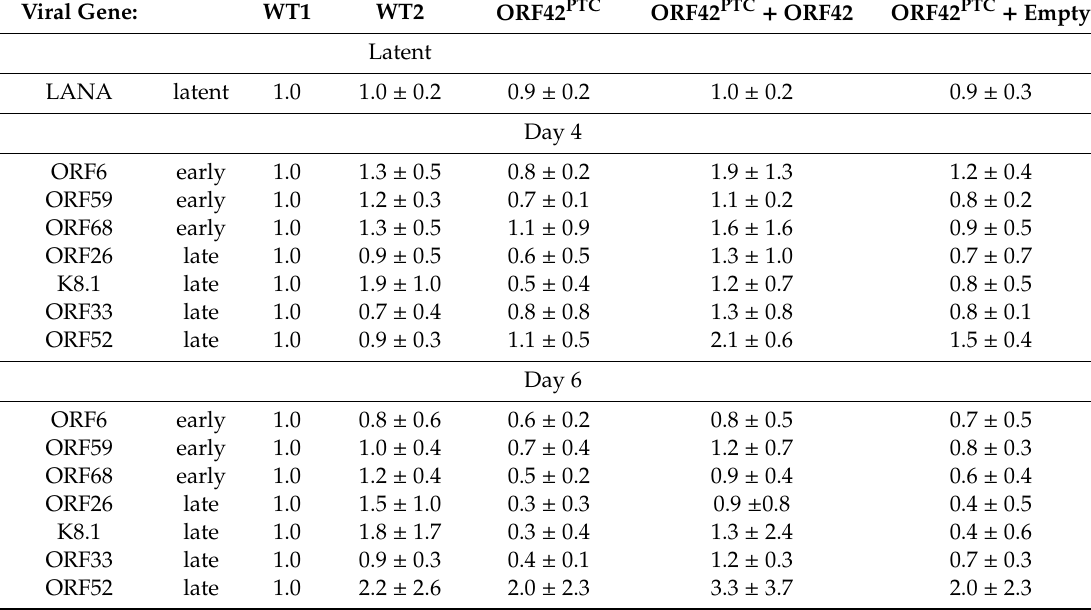
Table 2. Quantification of KSHV protein levels. Average expression and standard deviation of levels of KSHV proteins relative to the WT1 line. n ≥ 3 biological replicates—includes data from blots shown in Figures 1C, 2B, 4 and